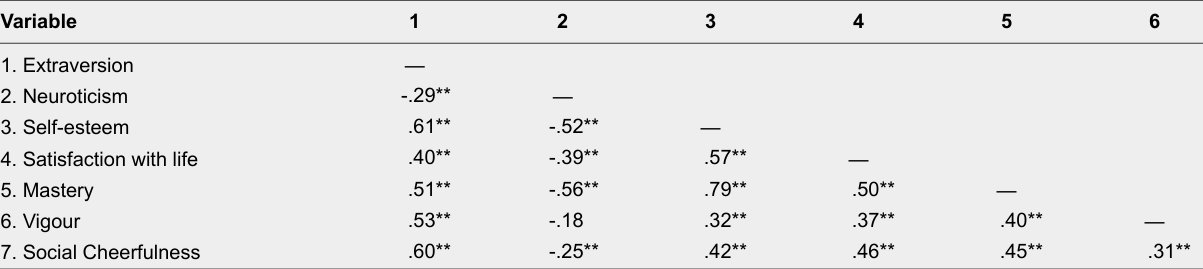
Correlations Between the Variables in the Measurement